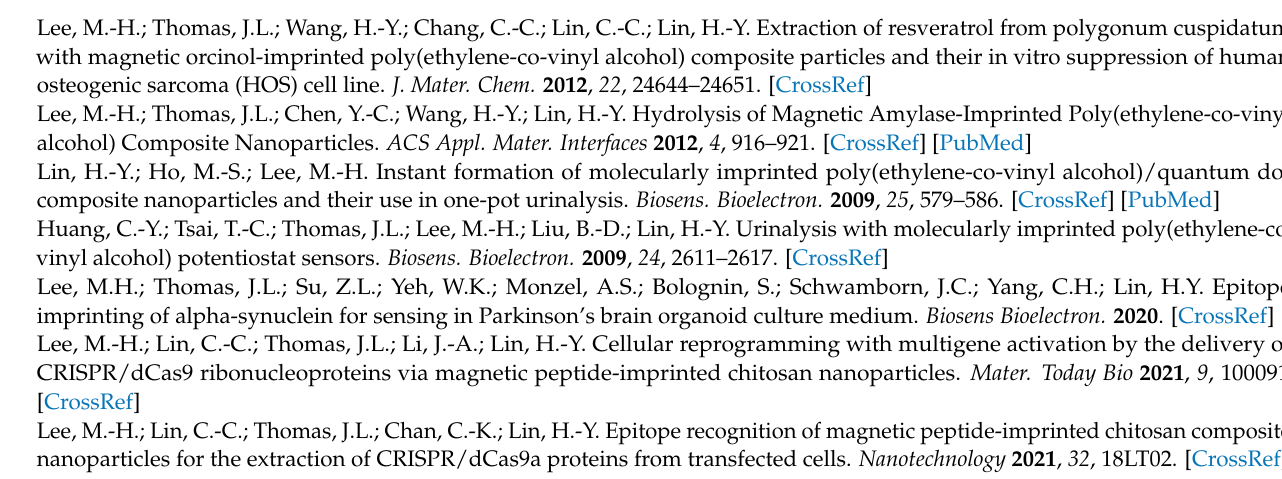
Figure S3. Optical, DAPI stained and merged images (from left to right columns) of (a) HepG2 cells; with MNPs (b); with MNPs/APTES (c), with MNPs/APTES/MC540 (d); and MNIPs/MC540 (e); Figure S4. (a) Immunostaining of CD-133 on HepG2 cells, (b) MPIPs/MC540 and (c) their merge image; Figure S5. Continuous cellular viability measurements of Hepa1-6 cells incubated with 100 µ g/mL of MNIPs, MPIPs and MPIPs/MC540 (a) without or (b) with